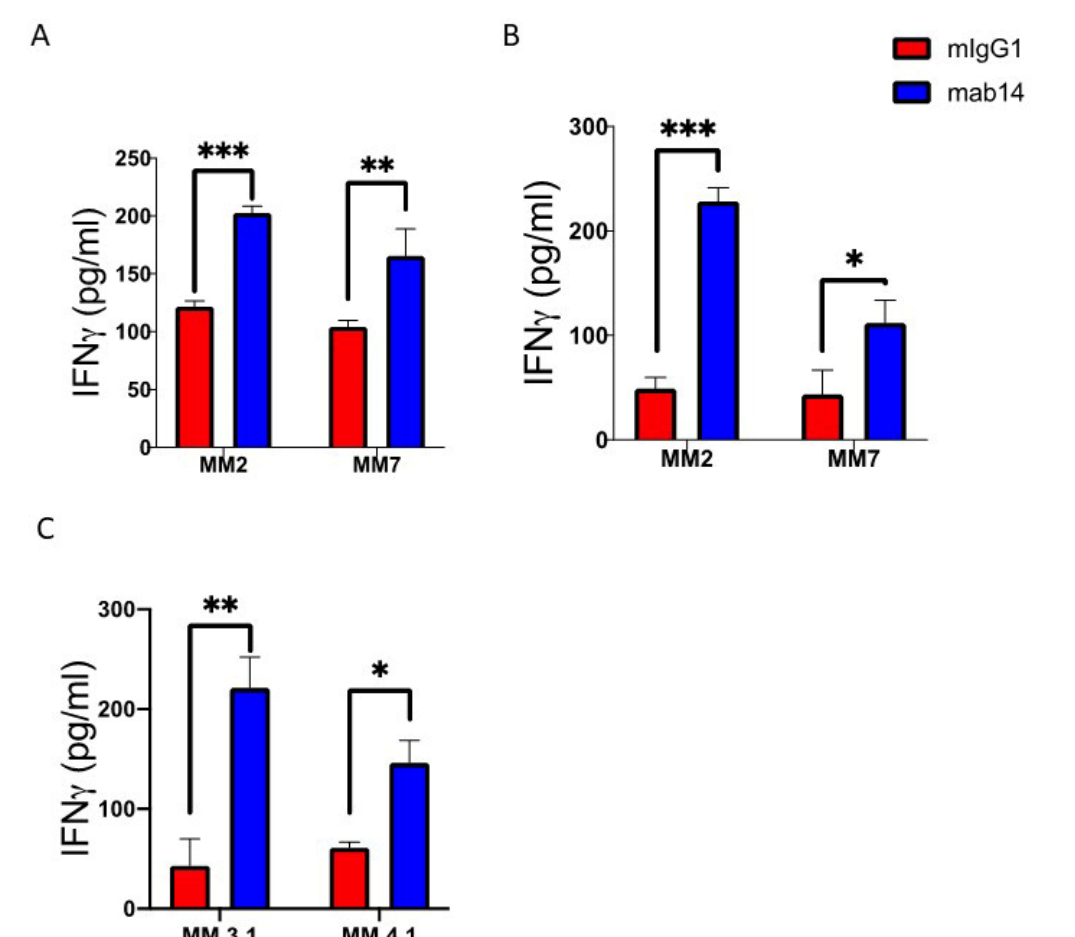
Figure 5. Blocking the membranal-PCNA on primary BM mononuclear cells from MM patients enhanced the activation of NK cells. ( A ) NKp44 isoform 1-transduced NK92 cells (NK92-44-1) were incubated either with Pat#MM2 or Pat#MM7 primary cells for 18 h. ( B ) Primary NK cells from a healthy donor were incubated either with Pat#MM2 or Pat#MM7 primary cells for 18 h. ( C ) Primary NK cells from another unrelated healthy donor were incubated either with Pat#MM3.1 or Pat#MM4.1 primary cells for 18 h. Mouse IgG1 was used as a background control (red bars) for mAb 14-25-9 (blue bars). IFN- γ was measured by ELISA. Data is shown of three technical replicates. Two-way ANOVA test showed p * < 0.05, p ** < 0.01, and p *** < 0.001. Statistical analysis and design were performed using Prism GraphPad v8.